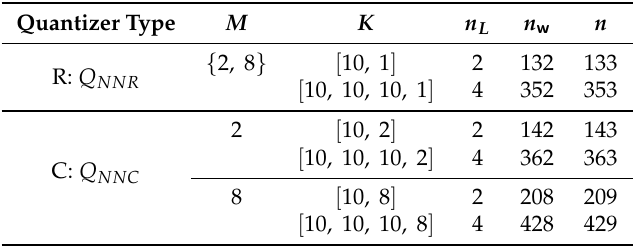
Table 1. Simulation